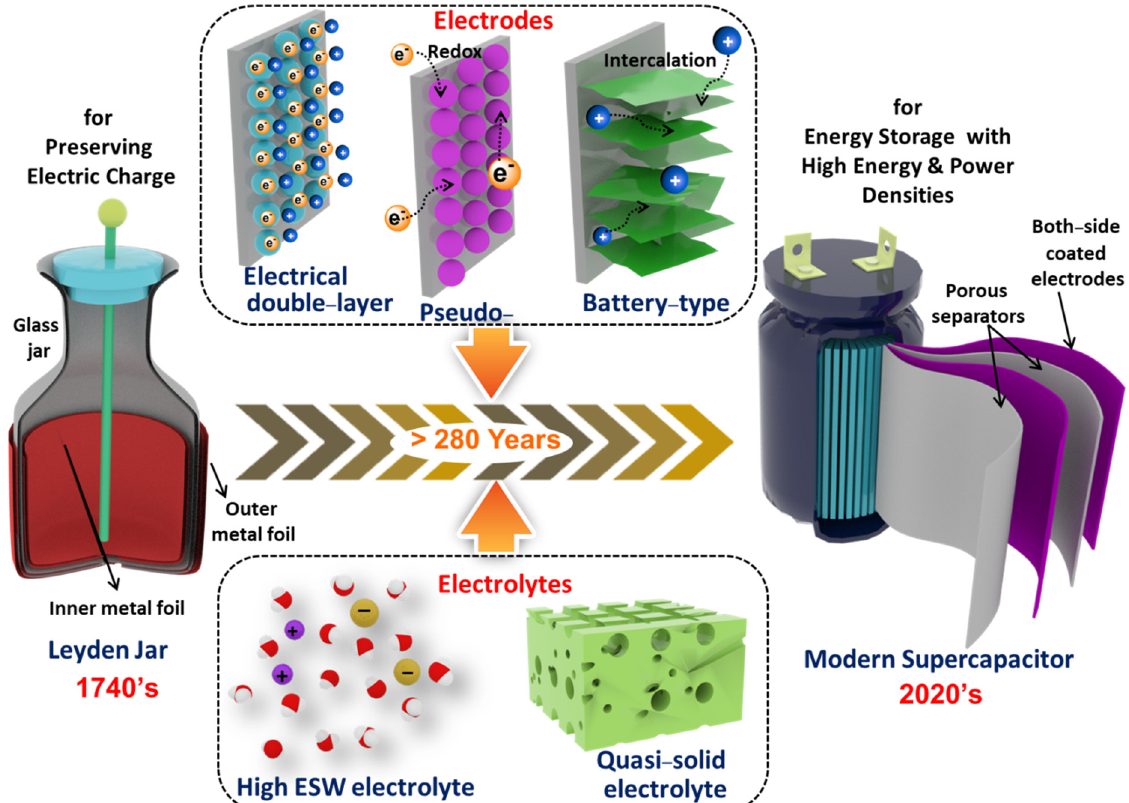
Figure 1. Schematic representation showing the evolution of modern supercapacitor devices through the various developments in their potential components.